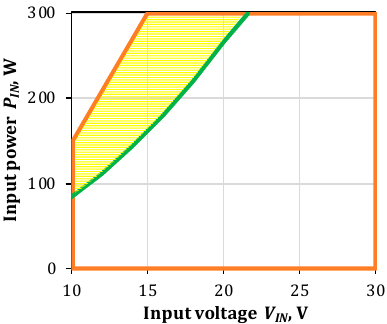
Figure 11. Comparison of the experimental limit of the input voltage and power regulation range in relation to the target operating range for the proposed and the baseline SRC topologies.